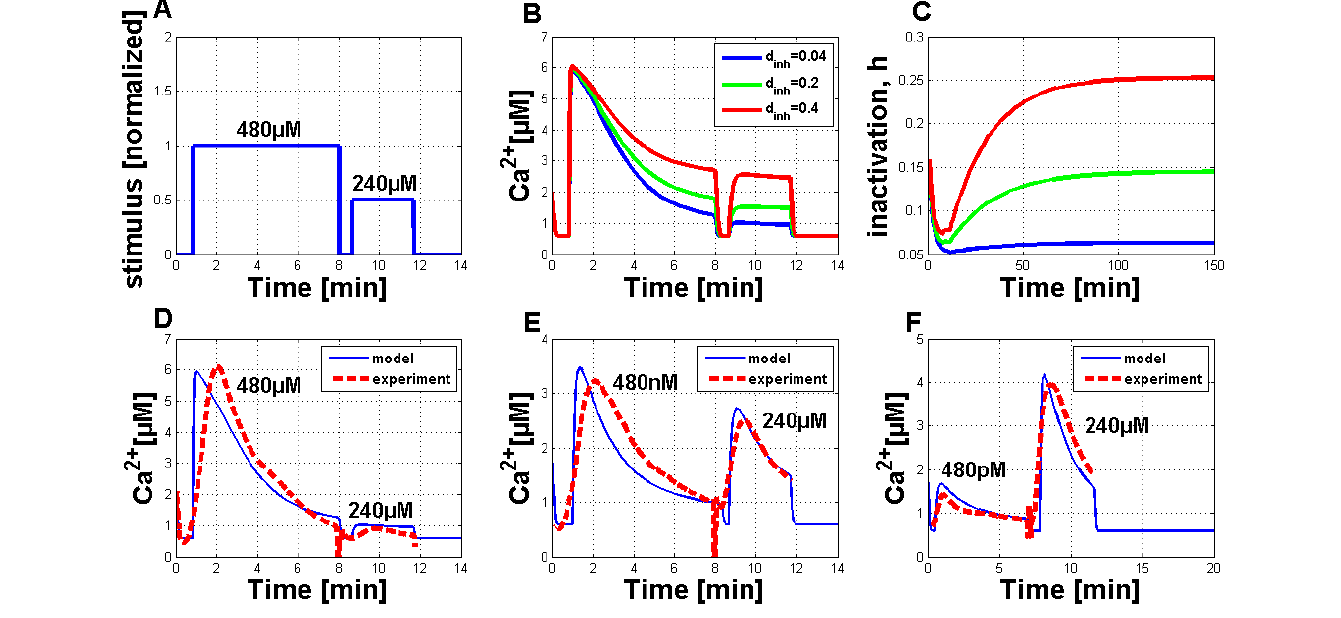
Simulation of Ca 2+ signatures with the adapted Li and Rinzel model and qualitative comparison to experimental Ca 2+ signatures, focusing on the stimulation at two different time points. ( A ) Normalized IP stimulus function for the activation of the x simulations in Figure 6B–D. The first elicitation was set to one as a normalized value, and the second elicitation was set to 0.5, related to stimulations with 480 µM and 240 µM of Ch5, respectively. In Figure 6E,F, the stimulus strength was changed. In Figure 6E, the first elicitation was set to 0.11 (corresponding to 480 nM) and in Figure 6F, to 0.06 (480 pM), while the second elicitation remained constant at 0.5 (240 µM). ( B ) Three different Ca 2+ simulations of the adapted Li and Rinzel model, activated by the same stimulus function as shown in Figure 6A. Only the parameter variation of d provoked different simulation inh results. The values of the other parameters were set as listed in Table 1, except υ = 200 1 and J = 0. ( C ) The corresponding inactivation processes for the Ca 2+ simulations in Figure in 6B are shown. The parameter set-up was the same as for the simulations in Figure 6B. The time interval of 2.5 h was chosen for a better illustration of process evolution. ( D ) + ( E ) + ( F ) Comparison of experimental (dashed red curve) and simulated (solid blue curve) Ca 2+ signatures upon elicitation with two consecutive Ch5 stimuli (6D: 480 µM and 240 µM, 6E: 480 nM and 240 µM and 6F: 480 pM and 240